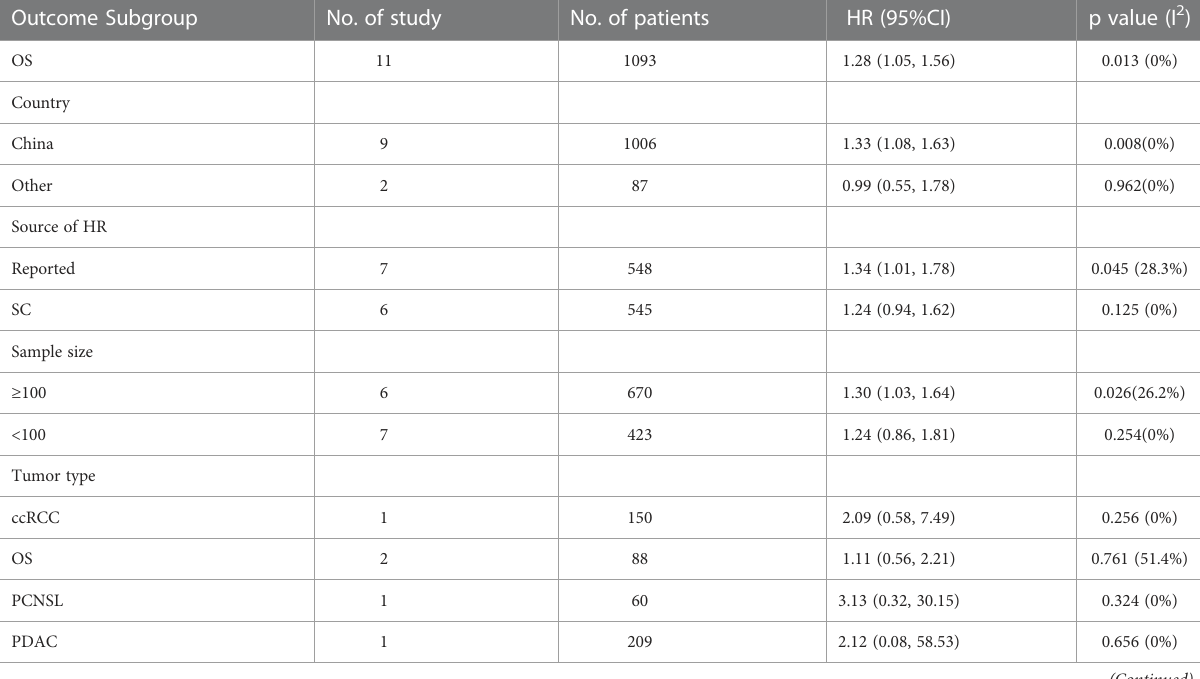
in Table 3. The relationship between Siglec-15 expression and OS was estimated, and the results are shown in Figure 2. According to the pooled analysis, Siglec-15 overexpression was signi fi cantly related with poor OS, with a combined HR of 1.28 TABLE 3 Pooled HRs for overall survival and subgroup analysis of Siglec-15 expression. Outcome